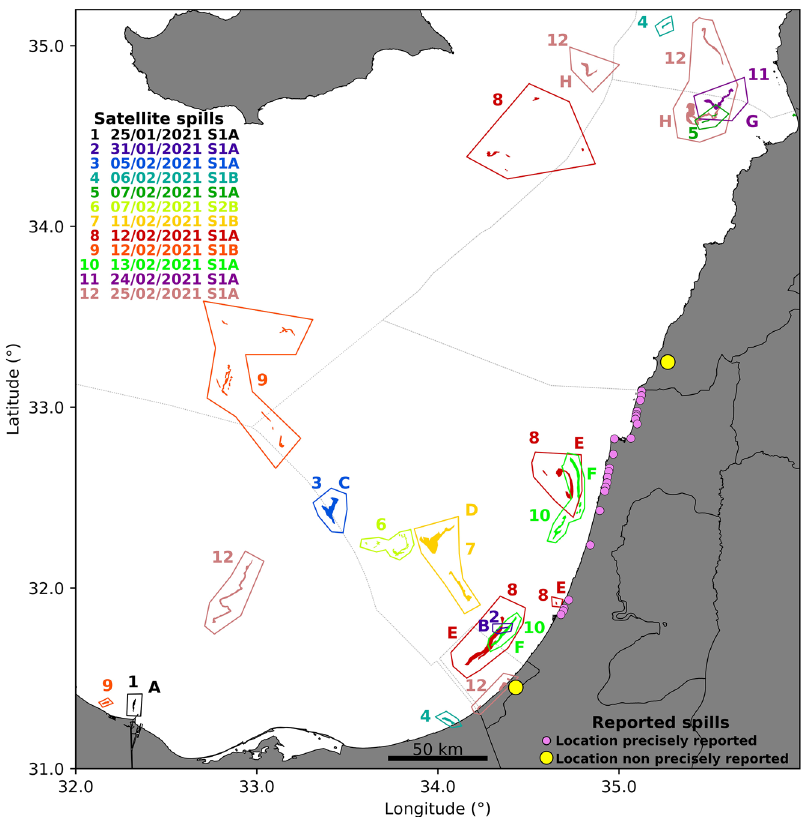
Figure 1. Scenario of affected areas. Exclusive Economic Zones (EEZ) are marked with a dotted line. Pink and yellow bullets mark coastal areas for which, according to mass media reports, there were in situ observations of oil or tar. Satellite observations are listed with numbers and colors according to the day in which they were detected. Some of them are double labelled with a letter since they are also reported in Fig. 2. The figure has been created using python 3.8.10 and matplotlib module 3.1.2 (https:// www. python. org/ downl oads/ relea se/ python- 3810/). Coastlines and country boundaries have been obtained from GSHHG—A Global